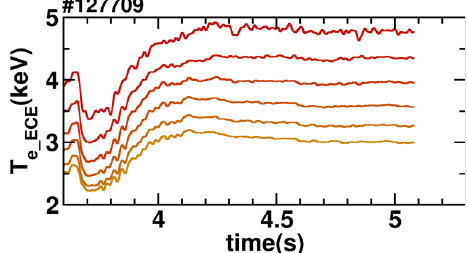
Fig.12 : Low pass filtered (f cutoff =40Hz) ECE measured at 0.144 m ≤ r eff ≤ 0.25 m in the same discharge of Fig.11.